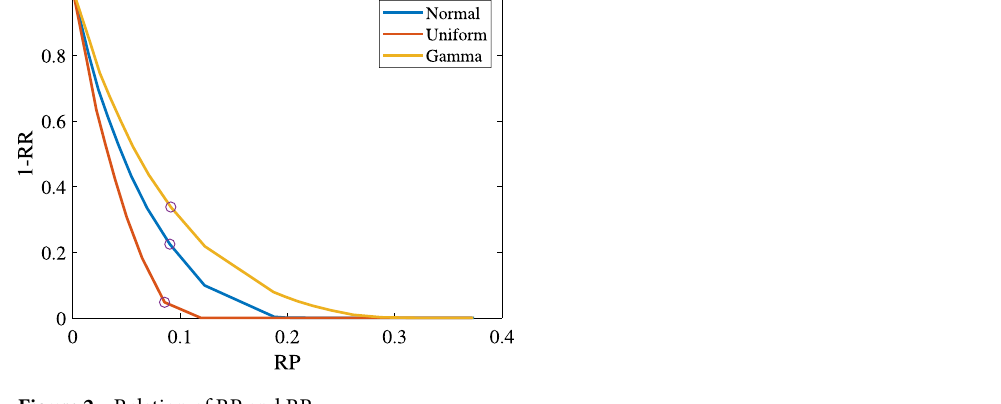
Figure 2. Relation of RP and